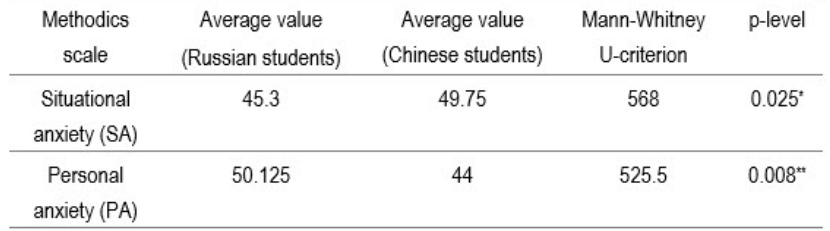
Results of establishing the significance of differences in the level of anxiety indicators in Russian and Chinese students